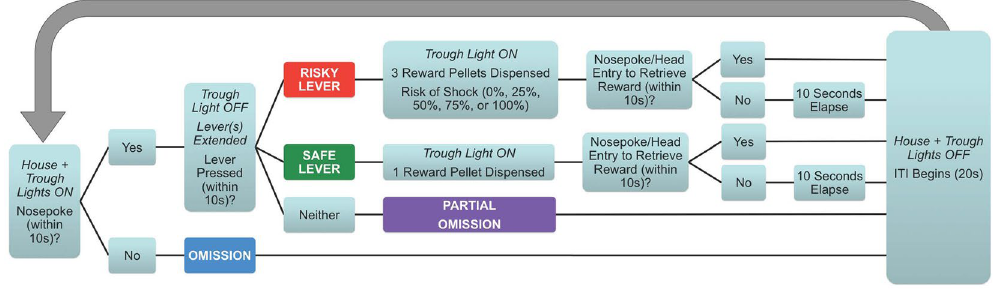
Figure 2. Risky decision-making task (RDT)